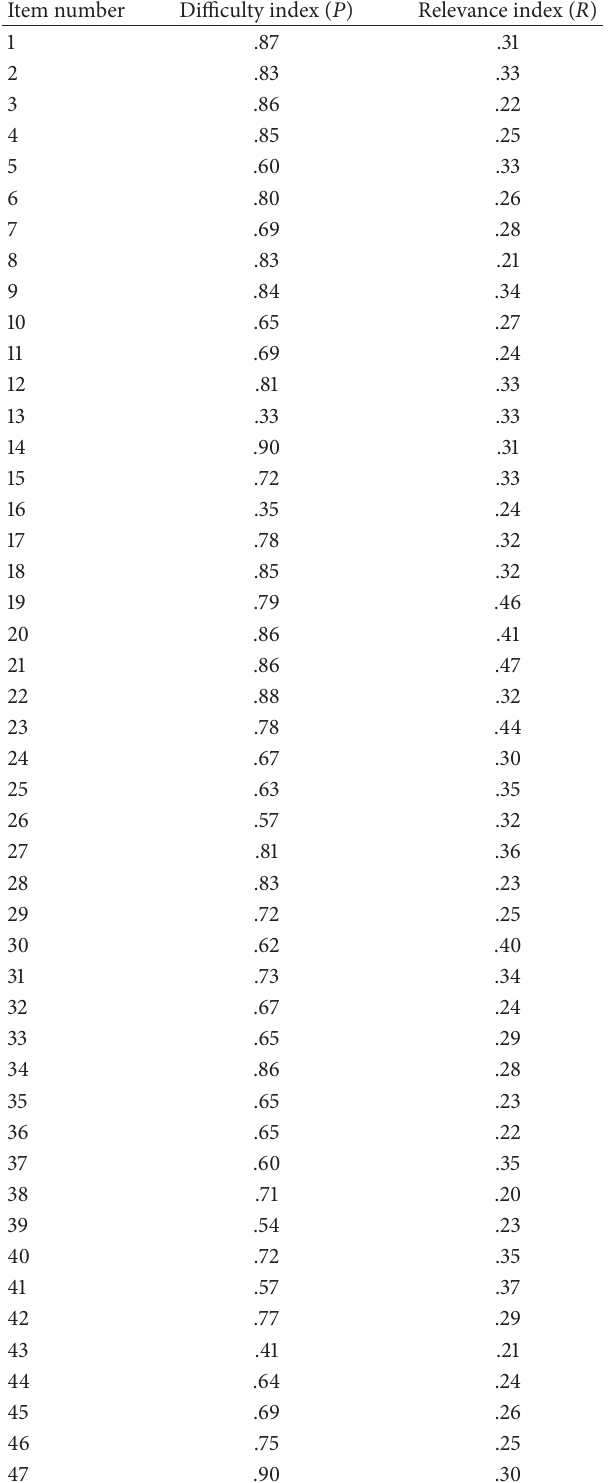
Table 1: Difficulty ( 𝑃 ) and relevance ( 𝑅 ) indexes of the